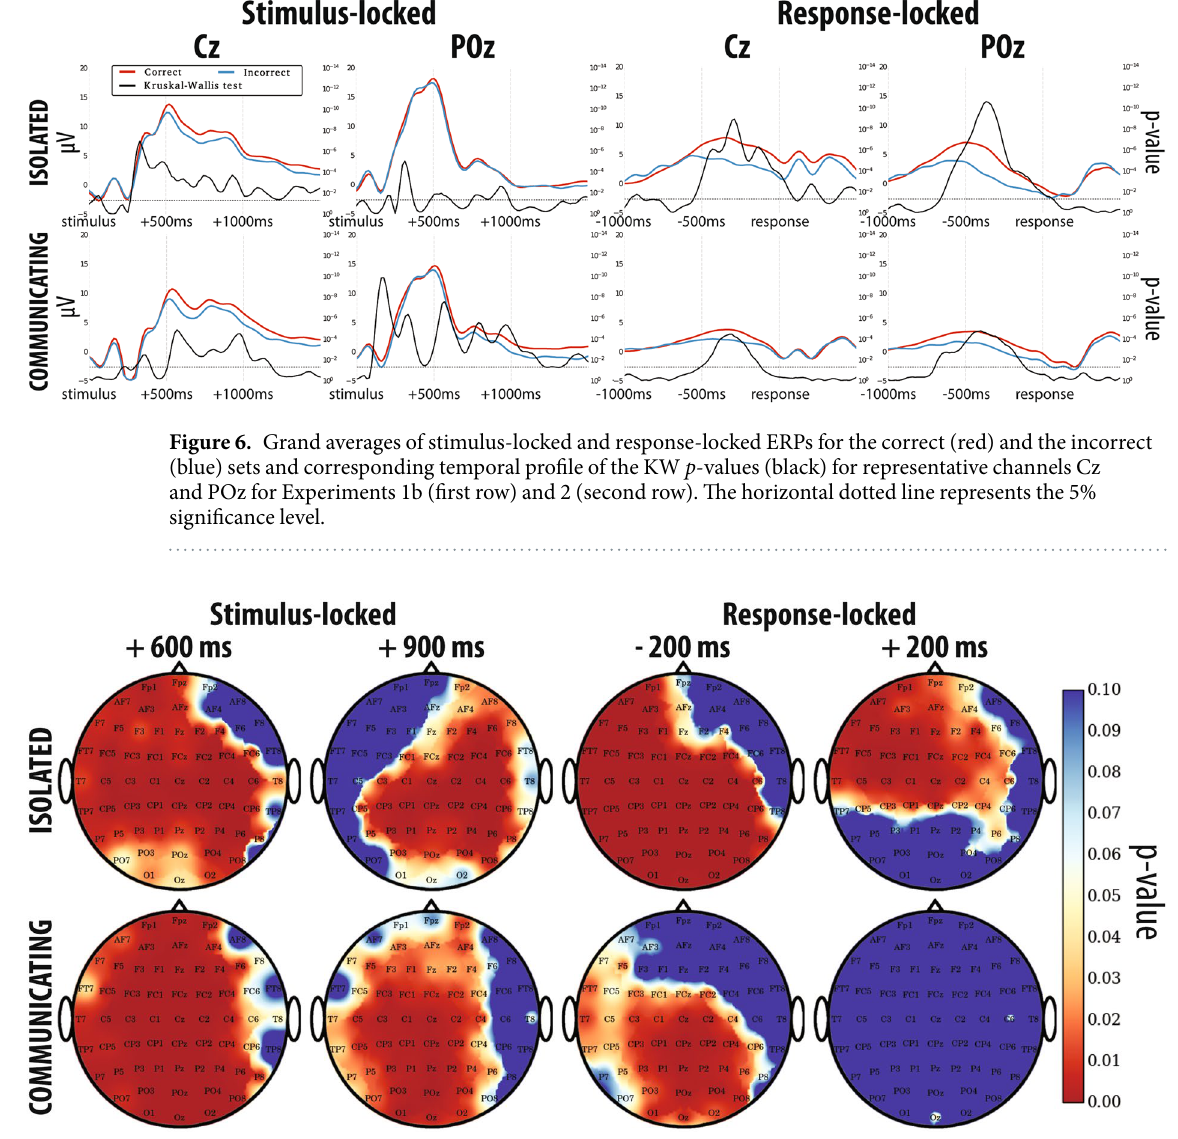
Figure 7. Scalp maps representing the p values of the Kruskal-Wallis test used to compare the grand averages of the EEG activity recorded 600 ms and 900 ms after the stimulus onset (first two columns) and 200 ms before and after the response (last two columns) for Experiments 1b (first row) and 2 (second